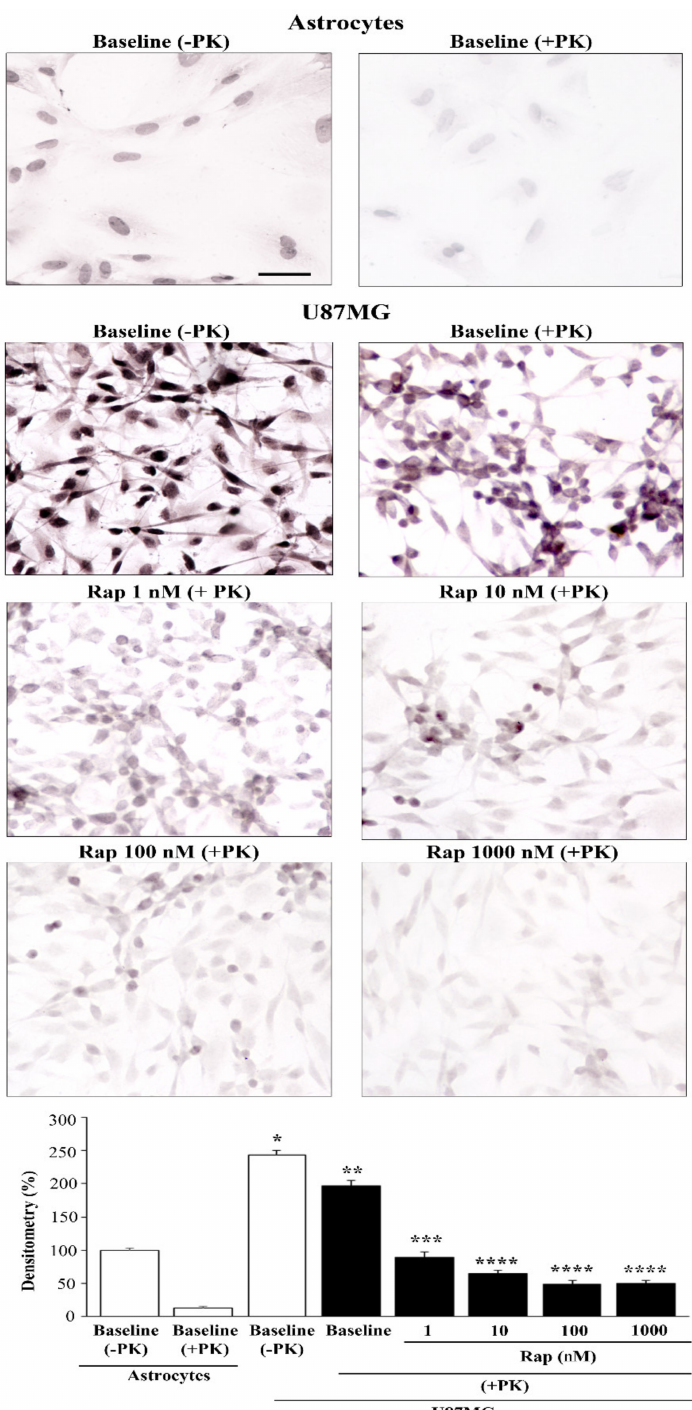
Figure 7. Rapamycin dose-dependently suppressed PK-resistant α -syn-immunostaining. Represen- tative pictures of total ( − PK) and PK-resistant (+PK) α -syn immunostaining within astrocytes and U87MG cells, in baseline conditions (baseline) and following increasing doses of rapamycin (Rap). The graph reports densitometry for α -syn immunostaining within astrocytes compared with U87MG cells, in baseline conditions and following various doses of rapamycin. Data are given as the mean percentage ± SEM of optical density from n = 30 cells per group obtained in N = 3 independent experiments (assuming controls as 100%). * p < 0.05 compared with astrocytes (baseline − PK); ** p < 0.05 compared with baseline ( − PK); *** p < 0.05 compared with baseline (+PK); **** p < 0.05 compared with baseline (+PK) and Rap 1 nM. Scale bar = 25.5 µ